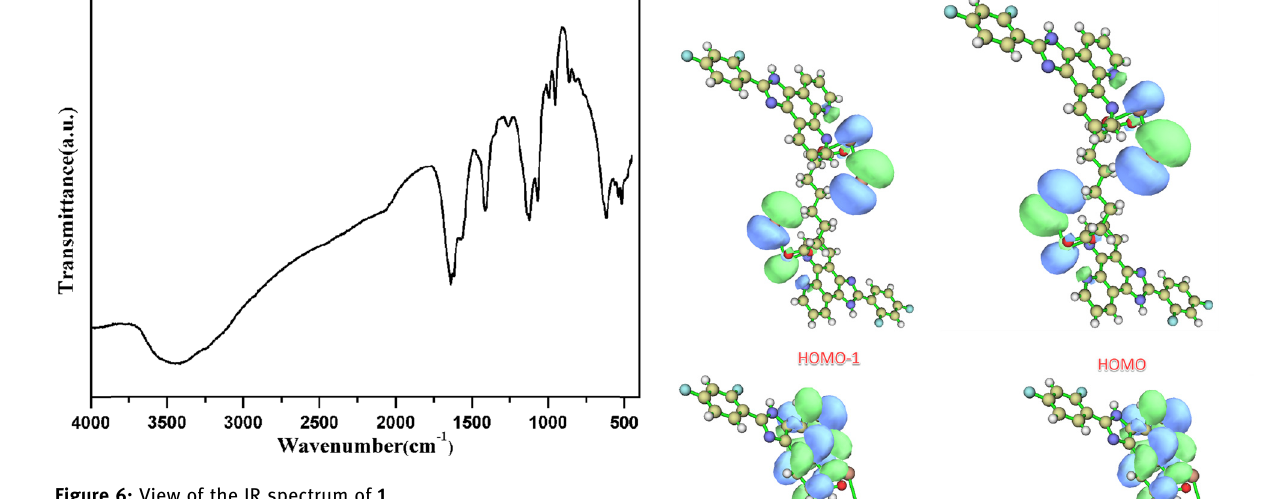
Figure 6: View of the IR spectrum of 1 .